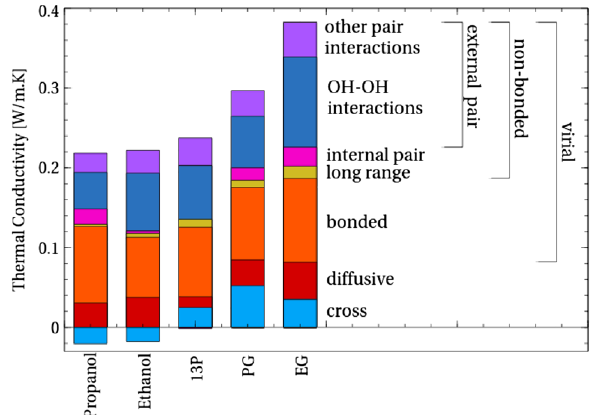
Figure 9. A summary of all the components of thermal transport within the molecules studied. The virial contribution to conductivity not only contributes the most to thermal conductivity for each molecule, but is also the driving contribution behind much variation between the molecules. Of this, the external (inter-molecular) hydroxyl group (OH–OH) contribution to conductivity is